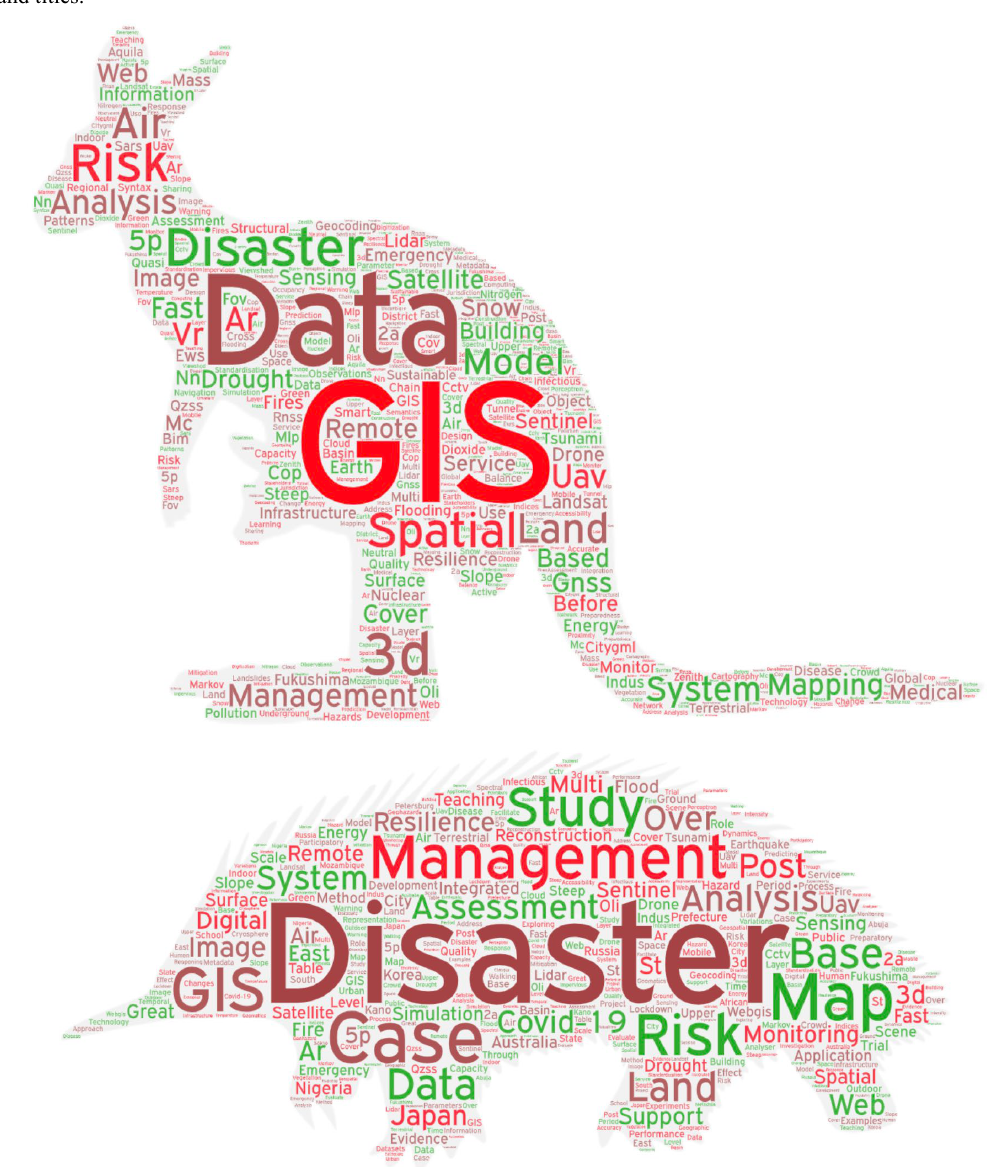
Figure 1: Word count of keywords (kangaroo) and titles